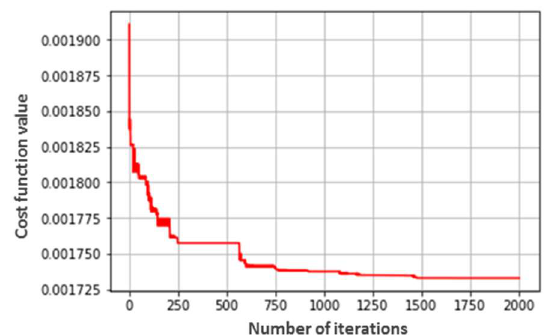
Fig. 4. Variation of the cost function as a function of iterations on a given spectrum.